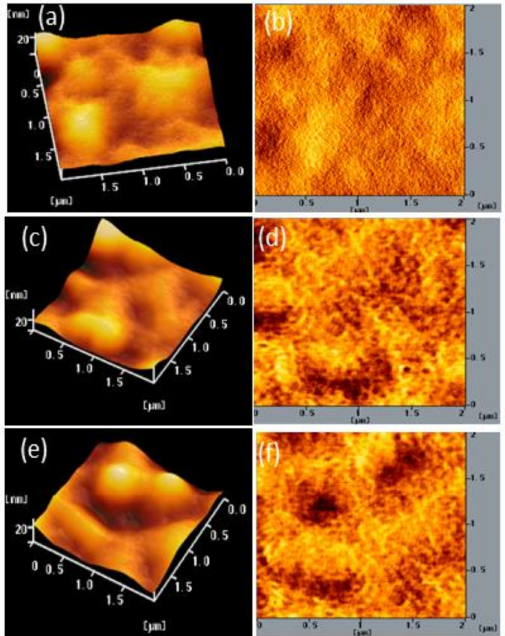
Figure 8. ( a , c , e ) Topographic and ( b , d , f ) phase AFM images of a BCP/PMMA (5:1, w / w ) film after storage at 30 ◦ C and 35% relative humidity for ( a , b ) 0, ( c , d ) 5, and ( e , f ) 10